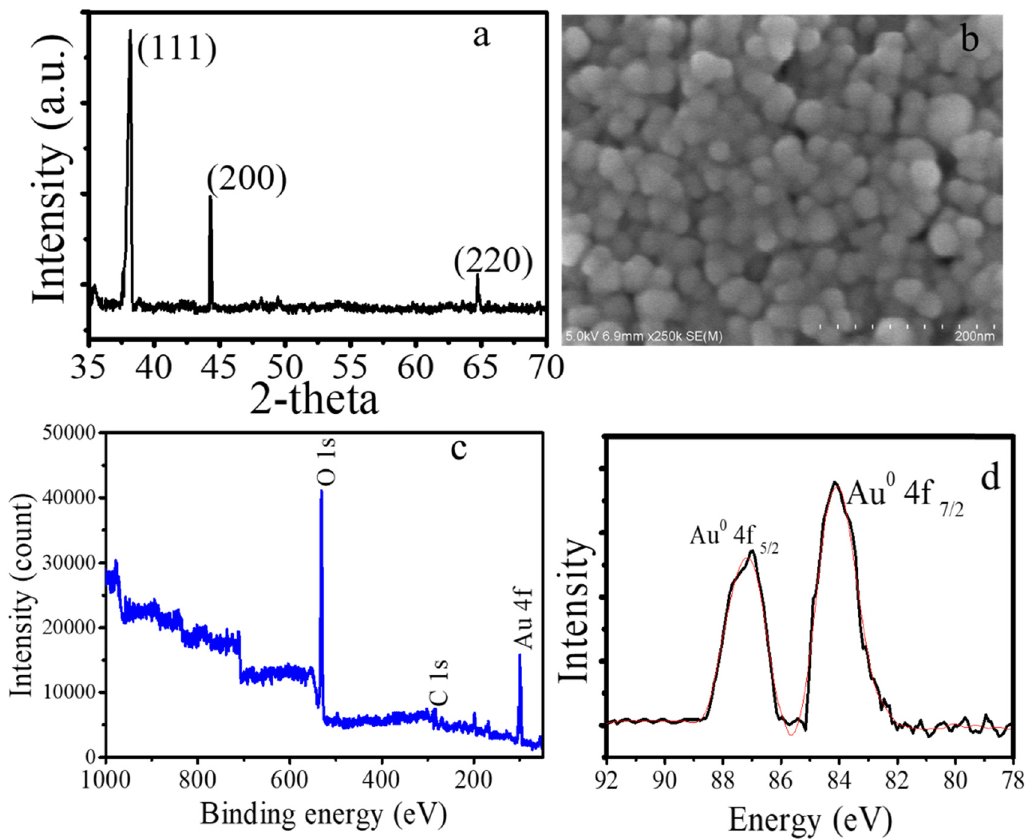
Figure 5: ( a ) XRD pattern of AuNPs, ( b ) SEM pro fi le of AuNPs, ( c ) survey scan spectrum of AuNPs, and ( d ) spectrum of Au